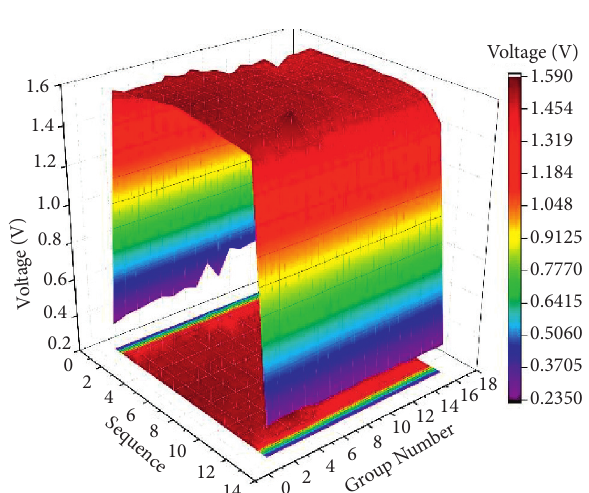
Figure 14: Plot of measurement data for interval excitation ref- erence measurement mode.